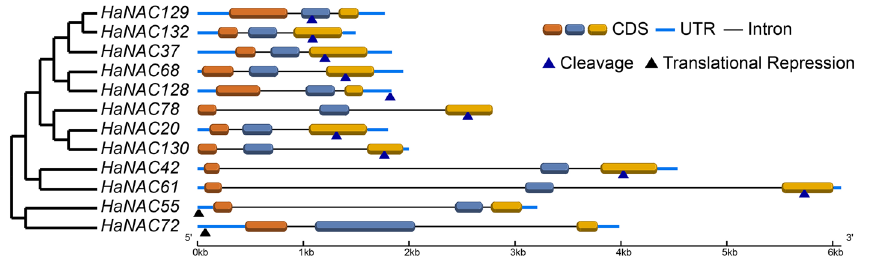
Figure 5. Phylogenetic tree and regulatory sites of HaNACs regulated by miRNA164s; Blue triangles indicated regulation of gene expression by cleavage, Black represented inhibition of mRNA